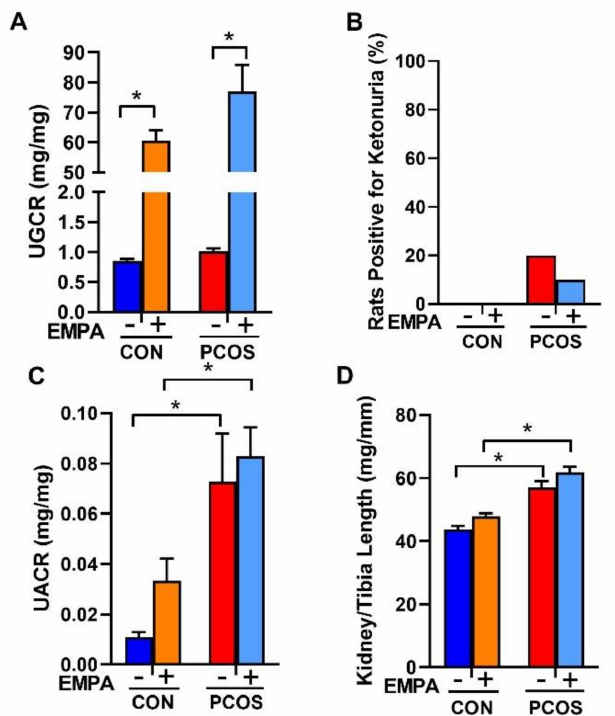
Figure 4. Effect of EMPA on urinary glucose, ketone, and albumin excretion on kidney hypertrophy in PCOS. Effect of EMPA on ( A ) urine glucose to creatinine ratio (UGCR), ( B ) urine ketone excretion, ( C ) urine albumin to creatinine ratio (UACR), and ( D ) kidney weight corrected by tibia length. Data are expressed as mean ± SEM. Data were analyzed by two-way ANOVA followed by Tukey post-hoc tests. No significant interactions were observed by two-way ANOVA. * p < 0.05. n = 7–10 per